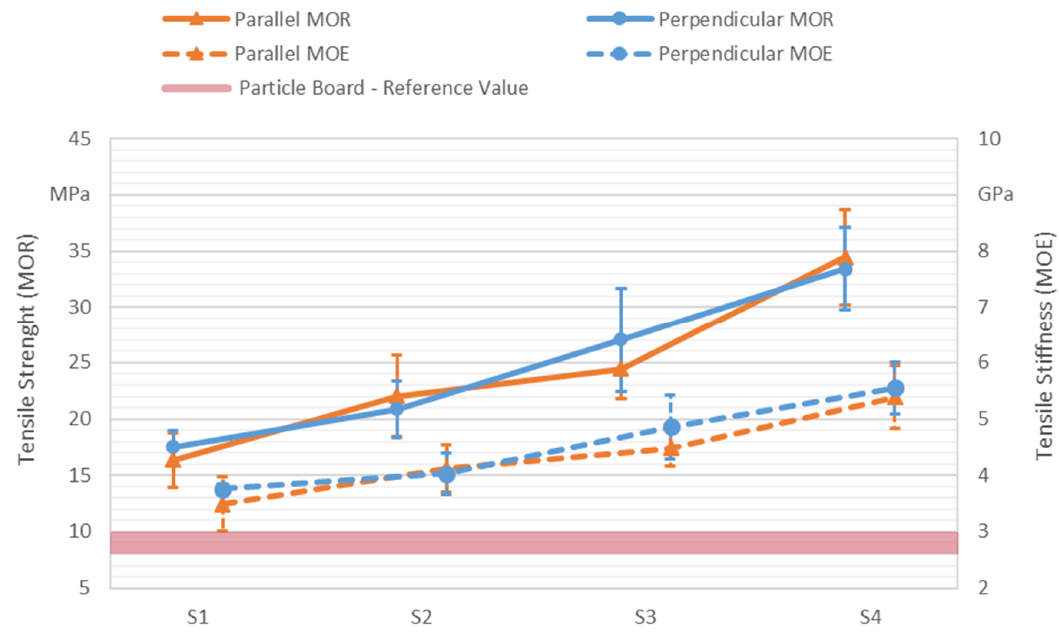
Figure 7. Results of tensile testing. Solid lines display values of the tensile strength (MOR), and dashed lines indicate values of the tensile stiffness (MOE). Orange triangles indicate the parallel orientation of specimens, and blue circles represent the perpendicular orientation of specimens. The red area contains the reference values of classical particle boards.